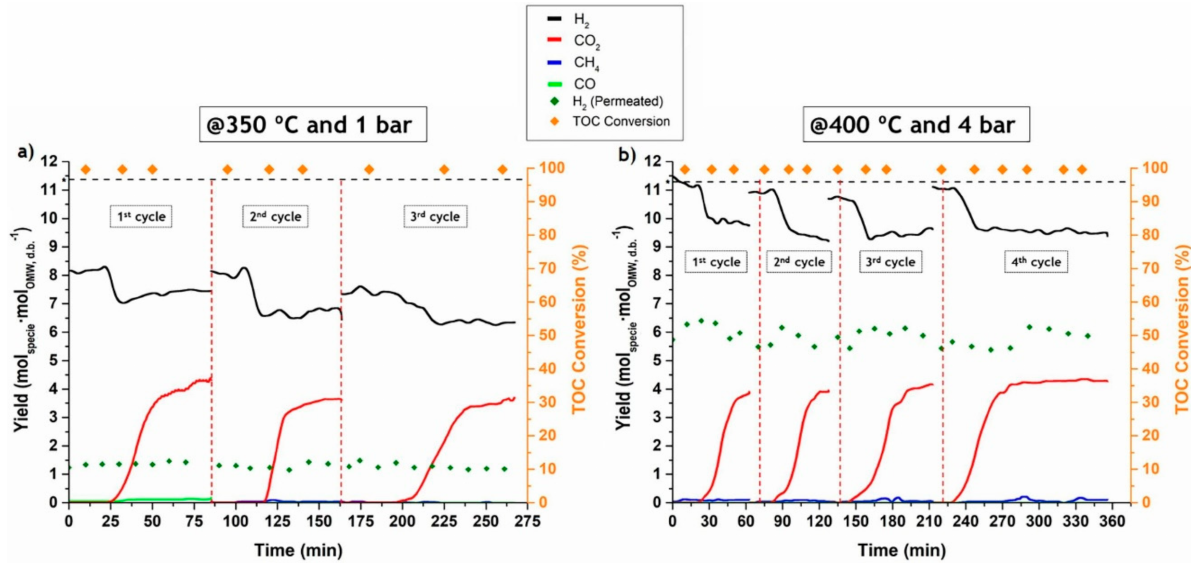
Figure 20. Gaseous species yield and TOC conversion using a SEMR operation at ( a ) 350 ◦ C and 1 bar and at ( b ) 400 ◦ C and 4 bar. Sweep gas = 100 mL N2 · min − 1 and P permeate side = 1 bar. * Thermodynamic equilibrium for the H 2 yield in a TR at the operations conditions used in the respective catalytic test (dashed horizontal line). Dashed red vertical lines indicate instants of reactive regeneration. Reprinted with permission from Ref. [197]. Copyright 2021